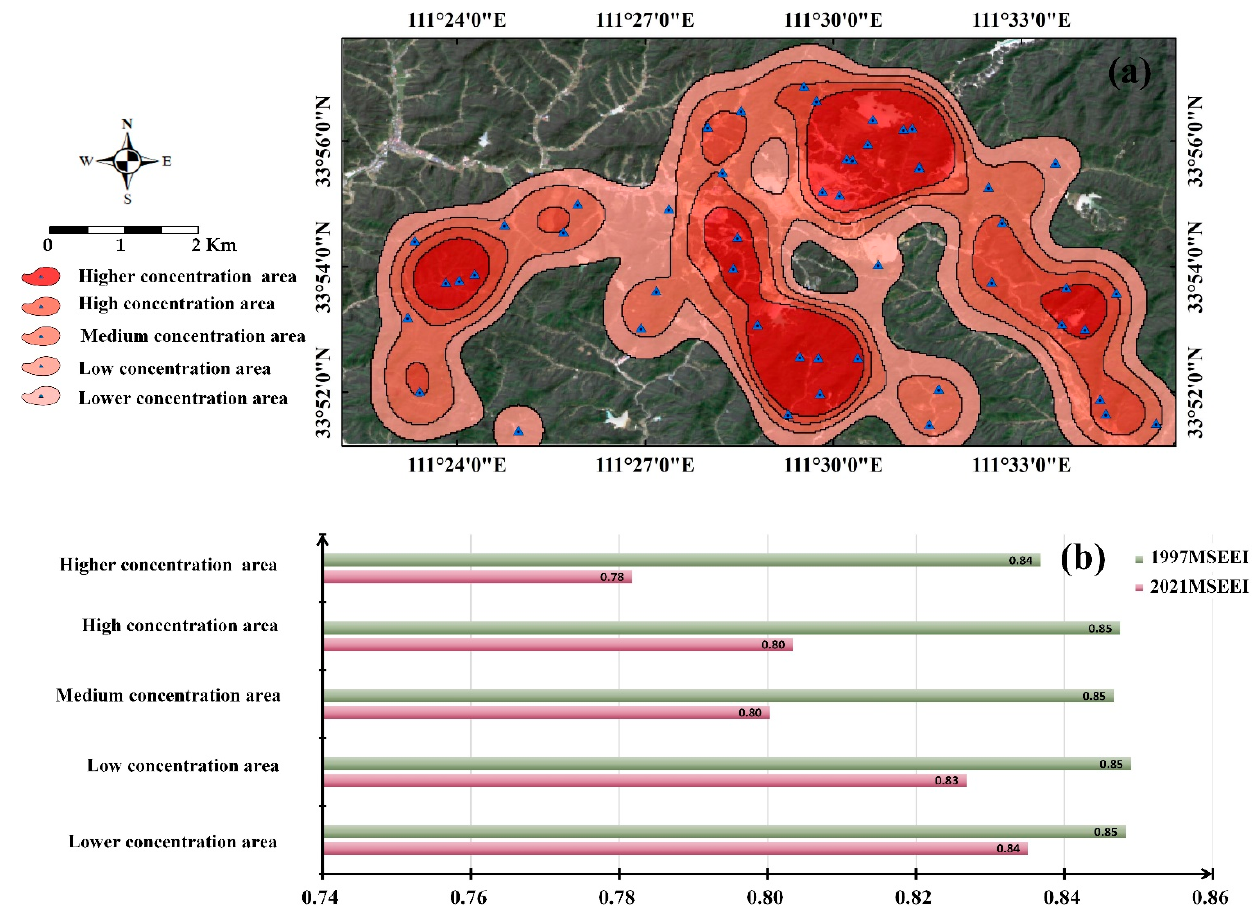
Figure 12. Nuclear density analysis diagram of mine points ( a ); MSEEI in 1997, 2021 ( b ).